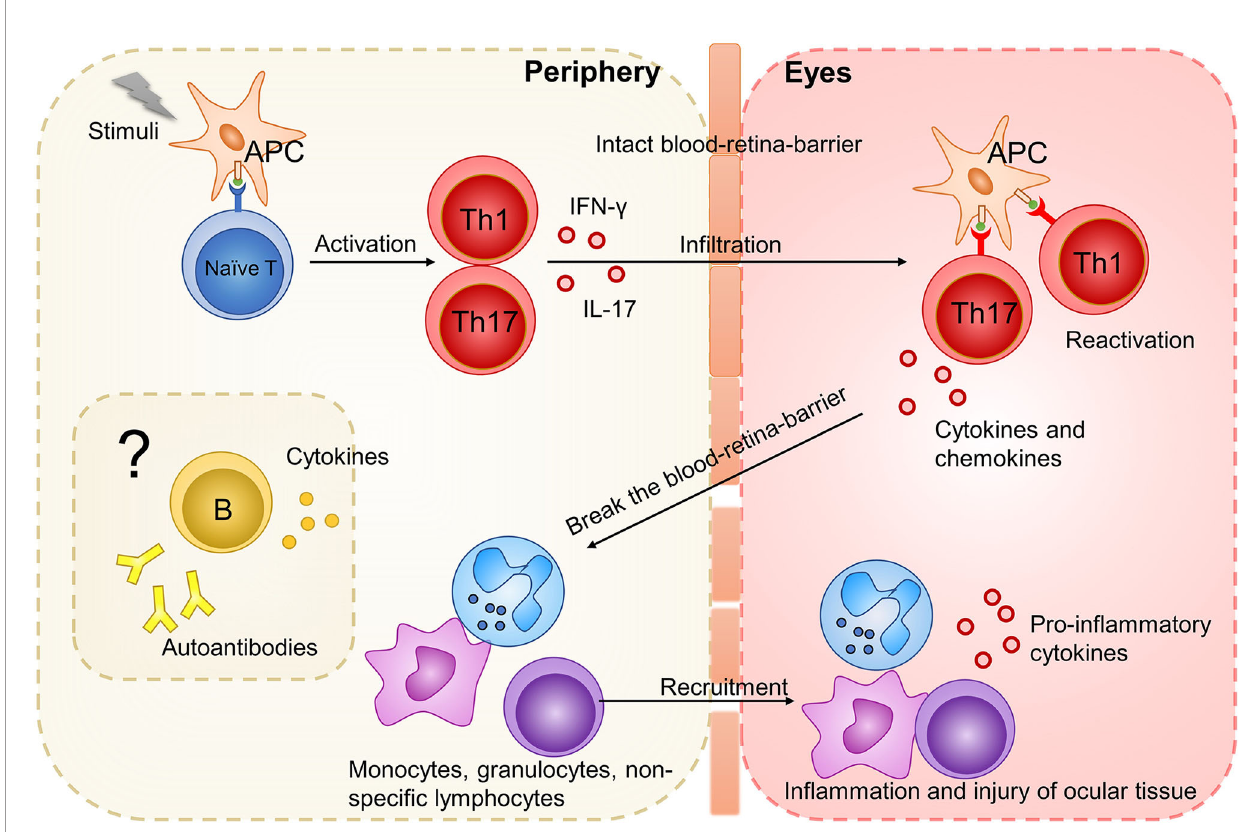
FIGURE 1 | The initiation of uveitis based on studies on EAU model. Stimuli (such as IRBP, pathogens with antigen mimicking ocular antigen, ocular autoantigen released from eyes) activate APC. APC present antigen to naive T cells and promote their differentiation into Th1 and Th17 cells. These activated Th1 and Th17 cells could in fi ltrate the intact blood-retina-barrier and be reactivated by cross-reactive ocular autoantigen. After reactivation, Th1 and Th17 cells secrete cytokines and chemokines, break the blood-retina-barrier, and attract in fl ammatory cells such as monocytes, granulocytes and non-speci fi c lymphocytes. These in fi ltrating in fl ammatory cells develop in fl ammation and further destroy the ocular tissue. How B cells function in this process is rarely